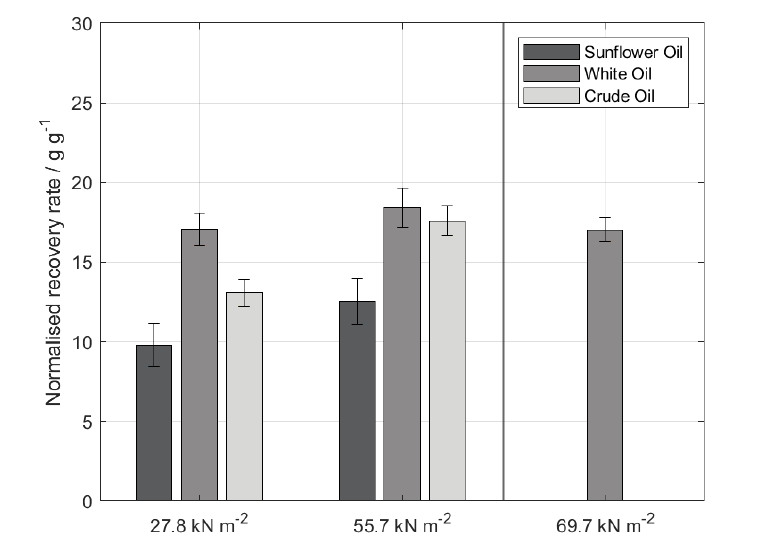
Figure 4. Left two datasets: Normalised recovery rate for all three used oil types as a function of squeezing pressure p squ of 27.8 and 55.7 kN m − 2 (n = 3 × 10 consecutive repetitions). Right dataset: Normalised recovery rate only for white oil at a squeezing pressure of 69.7 kN m − 2 (n = 3 × 50 consecutive